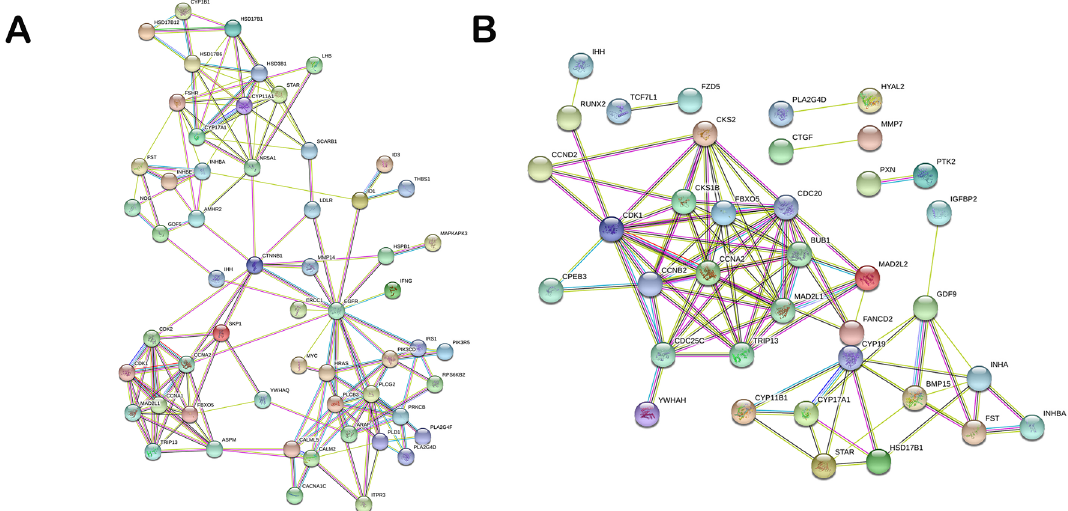
Figure 5. Protein–protein interaction network of differentially expressed messenger RNAs (mRNAs) related to ovary development. ( A ) Probable functional network of mRNAs in H1 vs H3. ( B ) Probable functional network of mRNAs in H3 vs H8. H1, H3 and H8 represent 1, 3 and 8 months old ovaries, respectively.